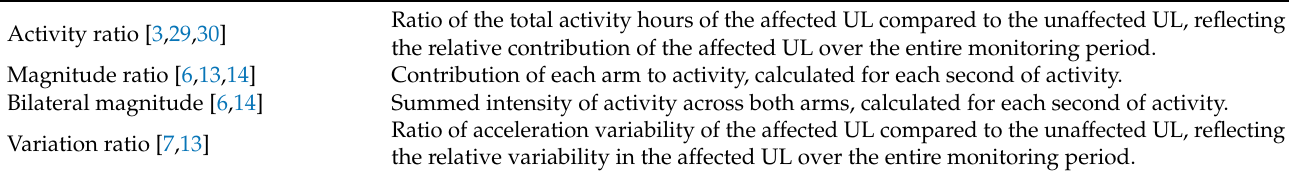
Table 1. Definitions for sensor